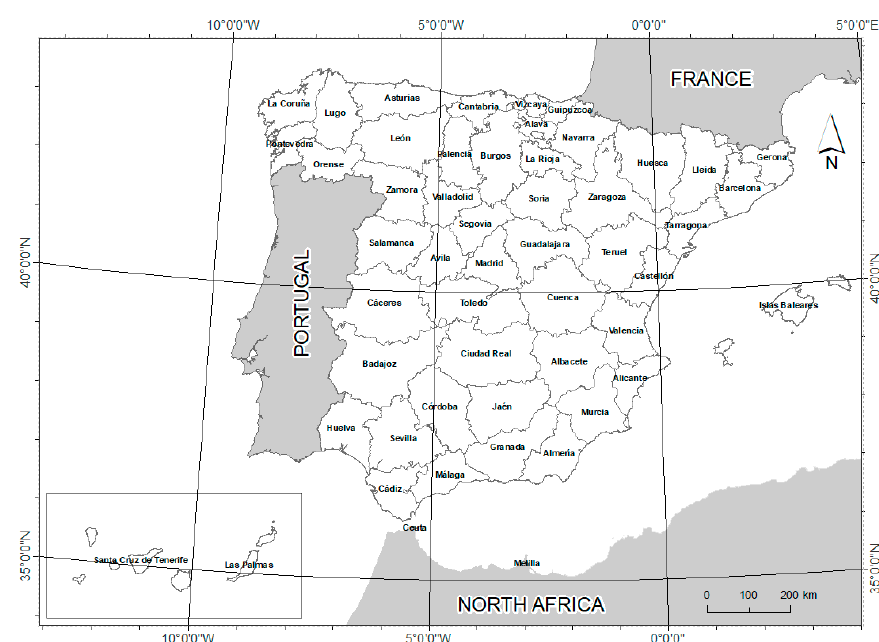
Figure A1. Map of the current regions of Spain.